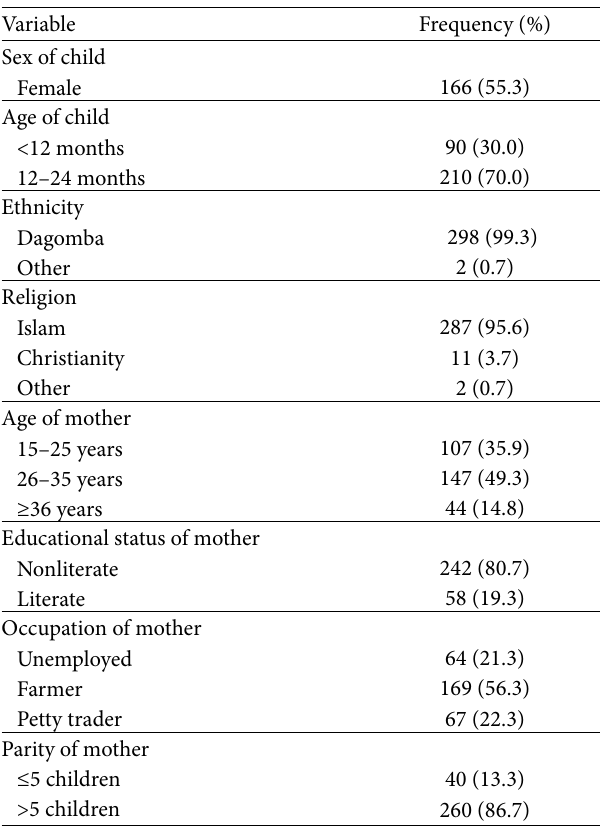
Table 1: Socio-demographic characteristics of the children and their